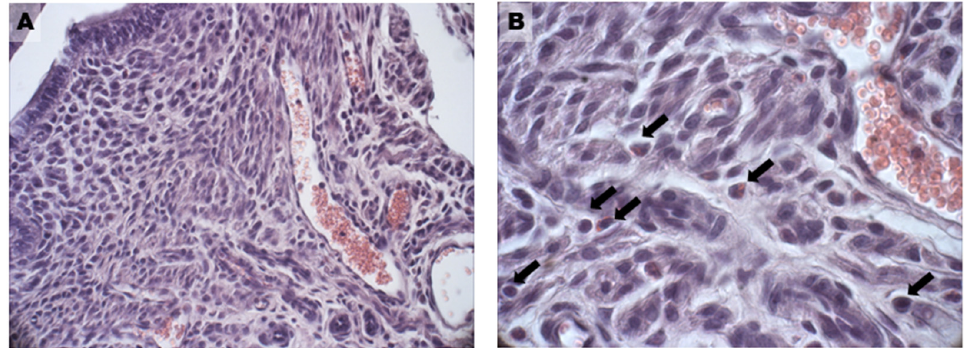
Figure 3. Abundant vascularization ( A ) and presence of inflammatory cells ( B ) in the endometrium of the DHEA group. Black arrows in ( B ) indicate single inflammatory cells as eosinophils, lymphocytes and macrophages. LM, 20x ( A ), 40x ( B ).